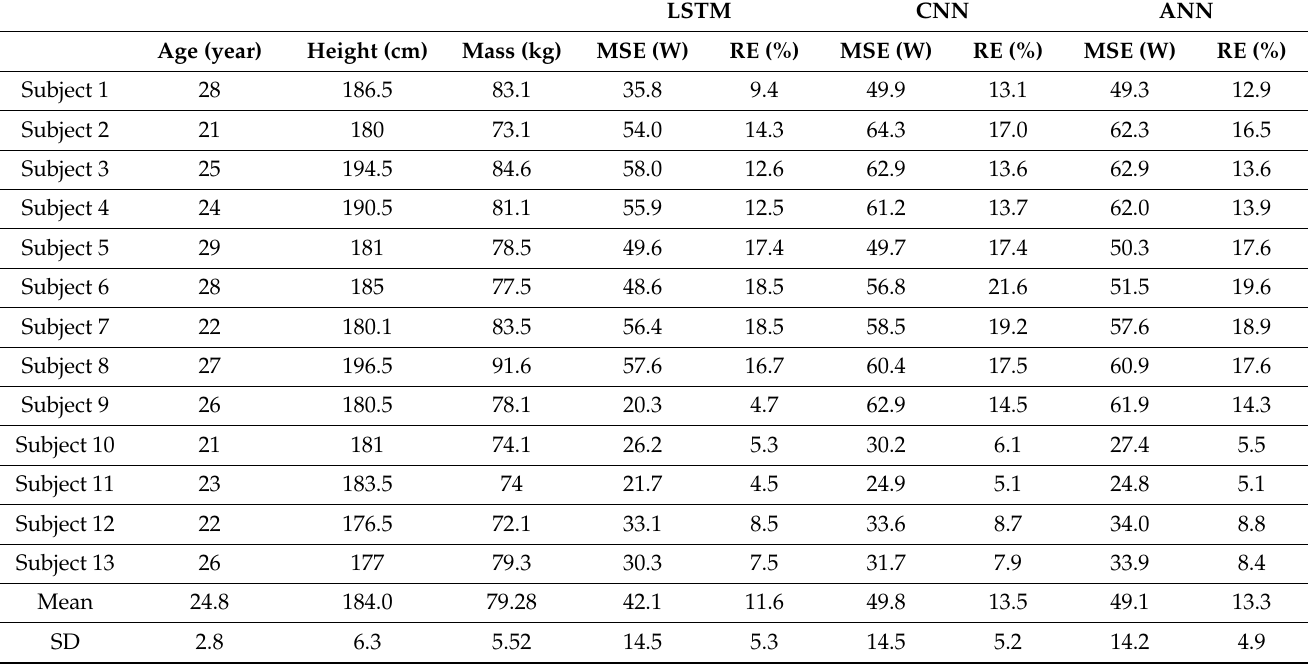
Table 2. Mean-squared errors (MSE) in watts (W) and relative error (RE) in % for each subject where the other subjects were used for training, using Long Short-Term Memory (LSTM), Convolutional Neural Network (CNN) and Artificial Neural Network (ANN).